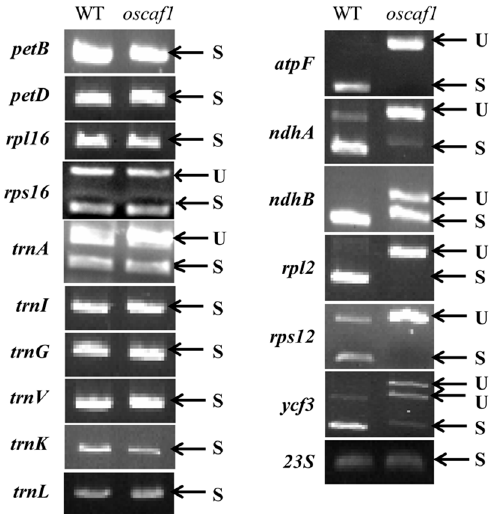
Figure 5. Splicing analysis of chloroplast gene transcripts in WT and oscaf1 mutants. U, unspliced transcripts; S, spliced transcripts.